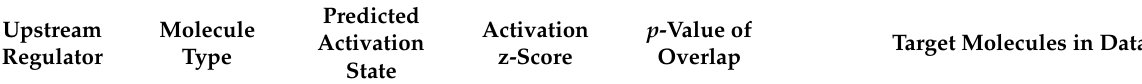
Table 3. Top 25 upstream regulators derived from IPA analysis of differentially expressed proteins obtained in the cytokines vs. control